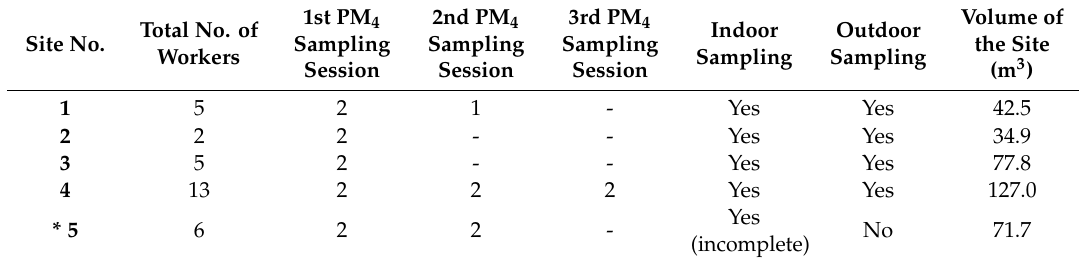
Table 1. Description of the sites and workers